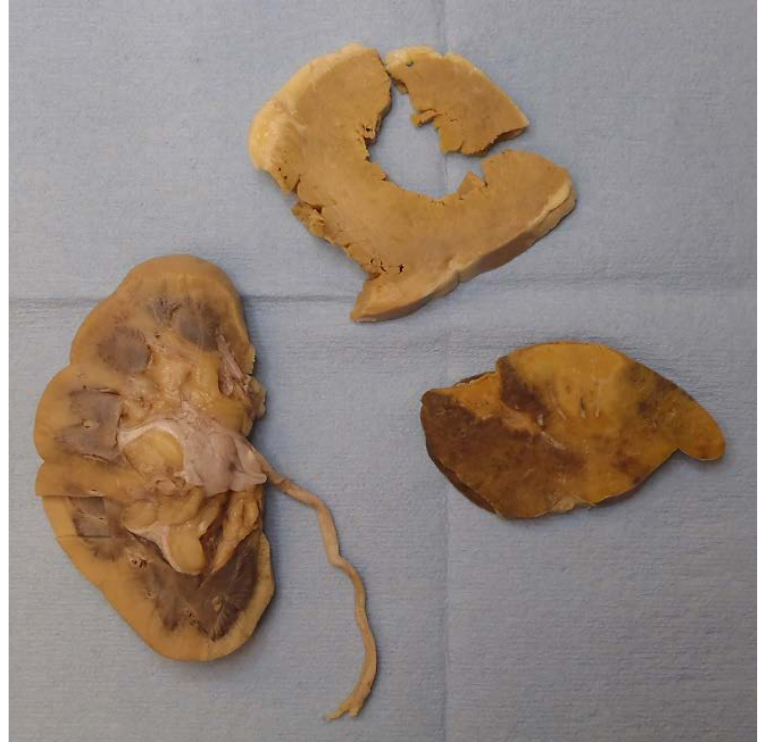
Figure 2. Starting in the bottom left and moving clockwise, the cortex of the right kidney, left ventricle of the heart, and spleen (lardaceous pattern) showed gross pale-yellow tissue, indicating amyloid deposit.